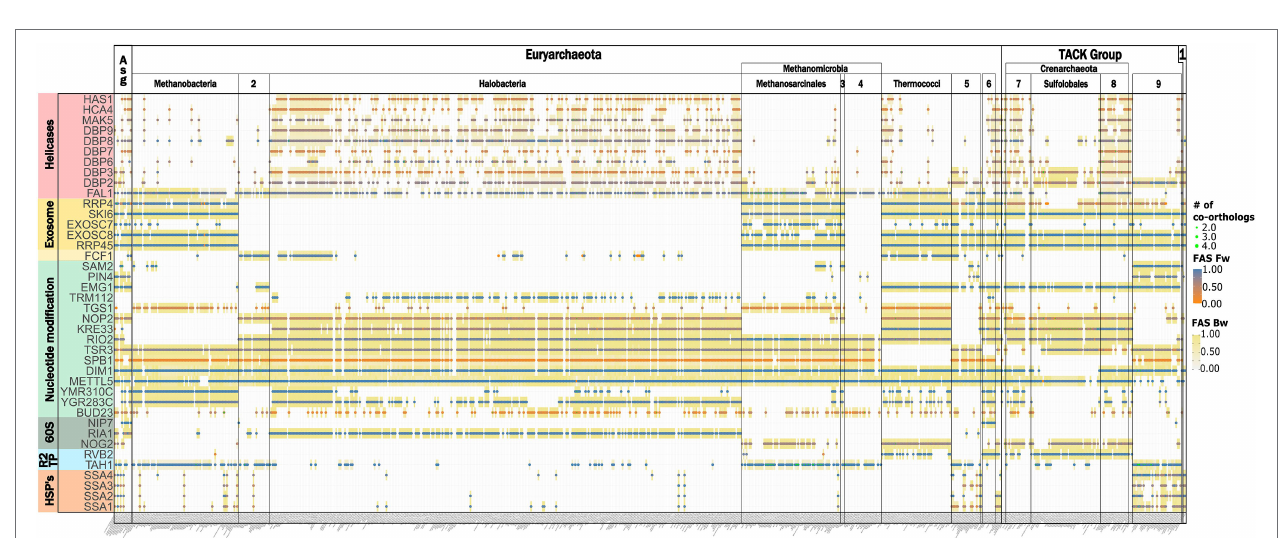
FIGURE 6 | The evolutionary traceability of the yeast RBFs. (A) The heat map reveals proteins and taxa for which the ortholog search sensitivity likely becomes a limiting factor (white to red areas). The phylogenetic profiles for proteins with a mean kingdom-wide traceability index (Ti) below 0.75 are shown in (B) summarized on a kingdom level. Abund – Fraction of taxa subsumed in a kingdom harboring an ortholog; FAS – maximum domain-architecture similarity between a yeast protein and the orthologs subsumed in this group. Background color represents the evolutionary traceability for the respective yeast protein.